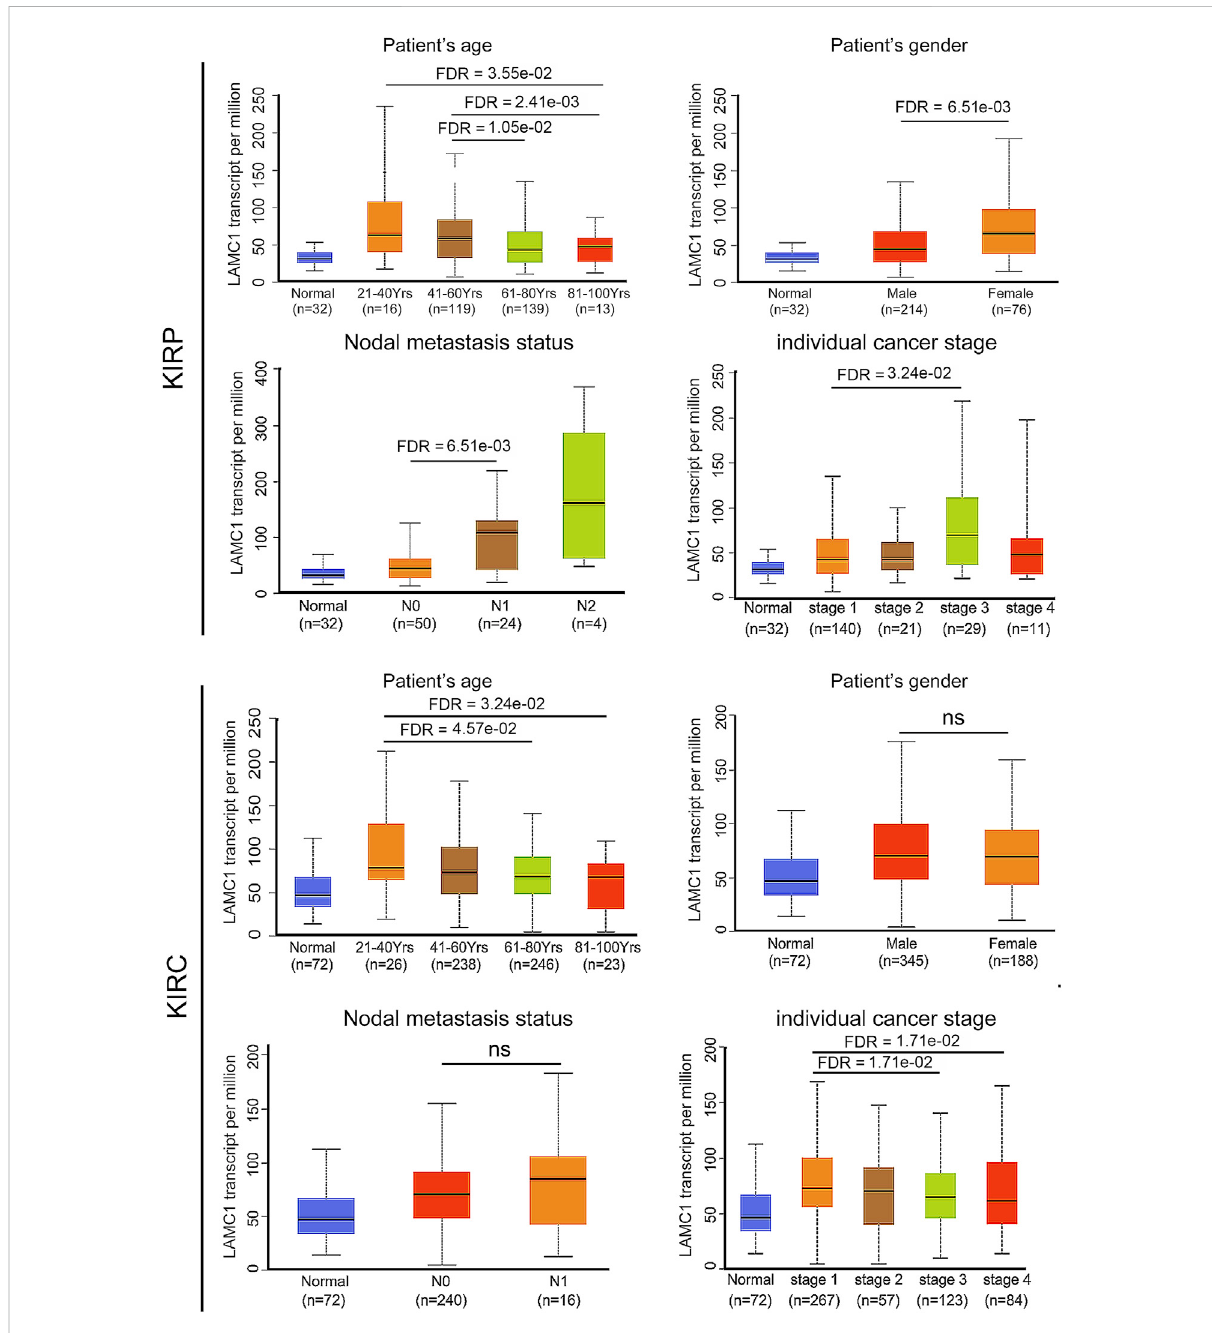
FIGURE 3 Therelationof LAMC1 expressiontotheclinicopathologicalfeaturesincludingage,gender,nodalmetastasisstatus, andindividualcancerstage in KIRP and